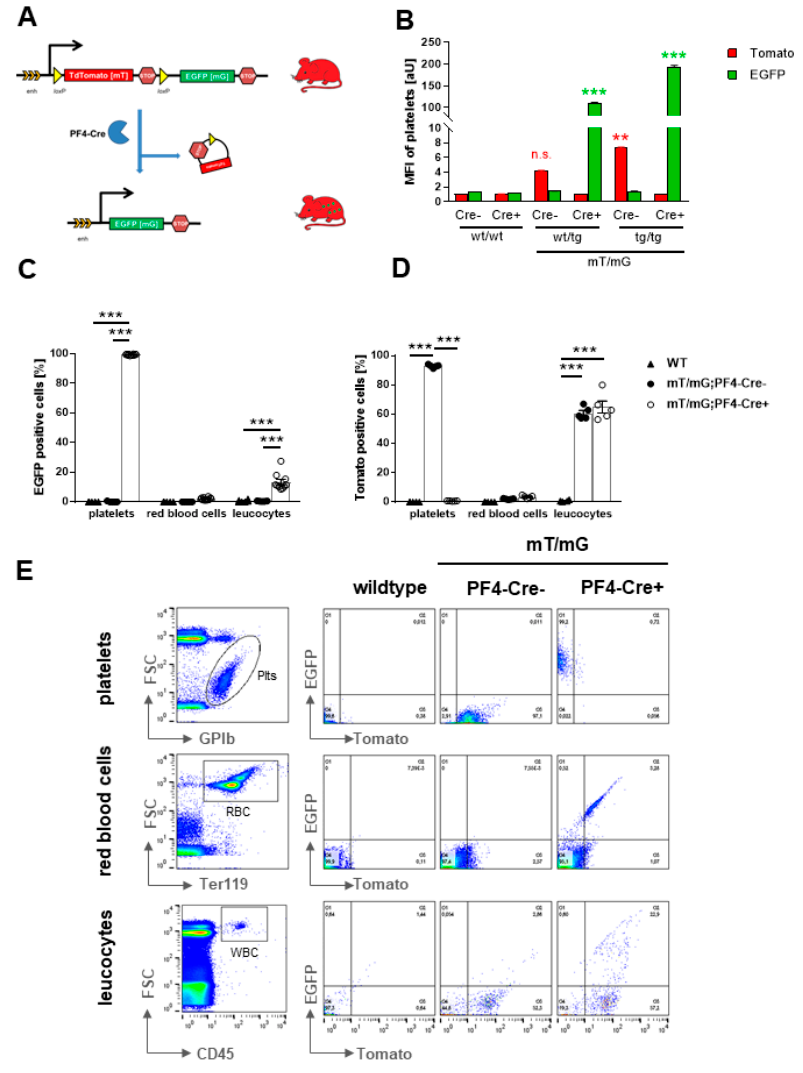
Figure 1. mT and mG fluorescence of blood cells in mT / mG ; PF4-Cre reporter mice. ( A ) Schematic dia- gram of the genetic construct of mT / mG ; PF4-Cre mice. The mT / mG construct consists of an enhancer (enh.) and a promoter (black arrow) region driving a loxP-flanked coding sequence of membrane- targeted tandem dimer Tomato ( mT ) resulting in tdTomato expression with membrane localization in every tissue. A stop codon inhibits the gene expression of membrane-targeted green fluorescent protein ( mG ). After Cre-mediated intrachromosomal recombination, the mT sequence is excised allowing the promoter/enhancer to drive the expression of mG in platelets and megakaryocytes. Yellow triangles represent loxP target sites for Cre-mediated recombination. ( B ) Mean fluorescence intensity (MFI) of mT and mG fluorescence in platelets regarding their specific side (SSC) and forward scatter (FSC) profile as determined by flow cytometry using whole blood of wildtype, heterozygous and homozygous mT / mG PF4-Cre negative and positive mice, n = 3–6. ( C – E ) Cell specific expression of mT or mG fluorescence was determined in platelets (DyLight649-labeled anti-mouse GPIb α ), red blood cells (APC-labeled rat anti-mouse TER-119) and leucocytes (APC-labeled rat anti-mouse CD45). Fluorescence signals were detected in the FITC ( mG ) and PE ( mT ) channels. ( C , D ) MFI of mG ( C ) and mT ( D ) fluorescent cell populations in washed whole blood of WT and mT / mG ; PF4-Cre negative and positive mice using flow cytometry, n = 5. ( E ) Representative dot blots showing the gating strategy for each cell population. The MFI of mG and mT fluorescence of different blood cells isolated from mT / mG ; PF4-Cre mice. Statistical analysis was performed by Two-way Anova Sidak (cid:48) s post hoc test ( A , B ) and Two-way Anova Tukey (cid:48) s post hoc test ( C , D ). Bar graphs depict mean values ± SEM, * p < 0.05; ** p < 0.01 and *** p <